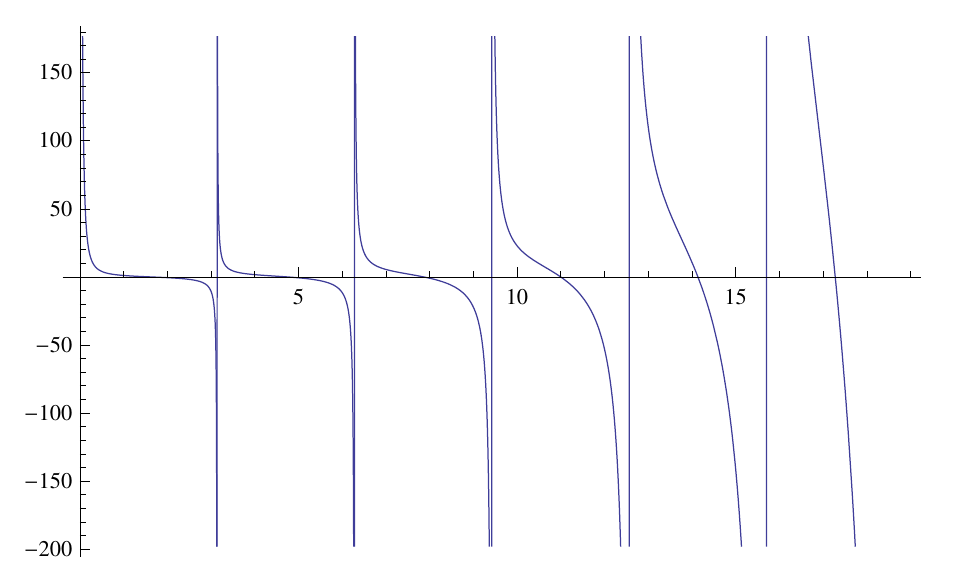
Figure 1. The graph of h(x) and its